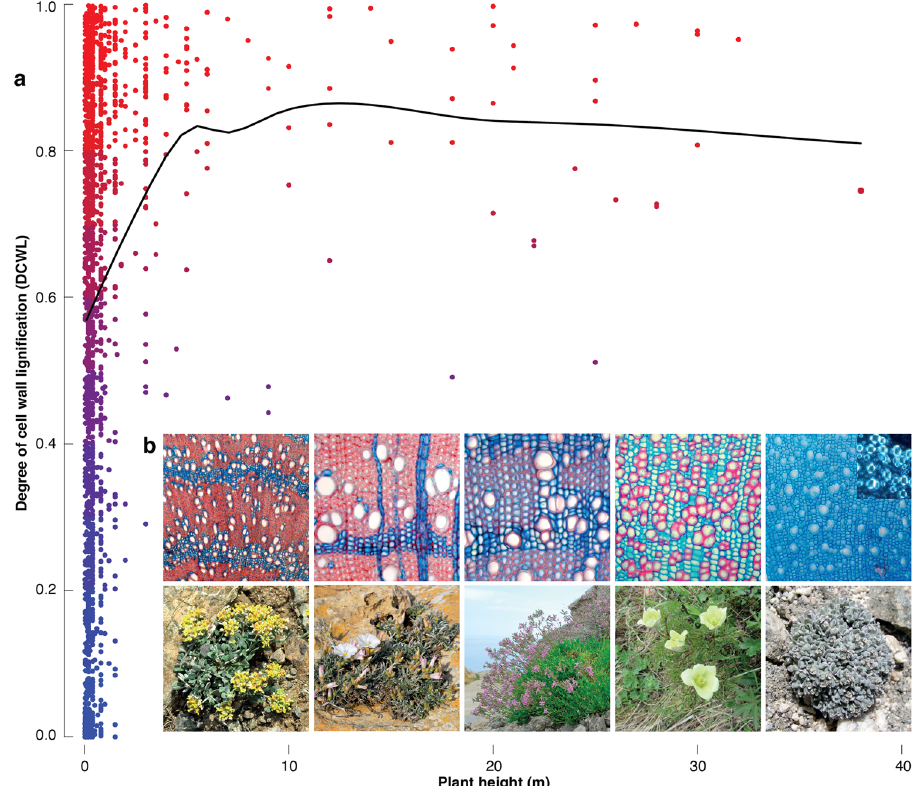
Fig. 4 Relation between cell wall ligni fi cation and plant height. a Dots represent 1770 different species (i.e., one sample per species), with colours ranging from blue (less ligni fi ed) to red (ligni fi ed). The curve is a locally weighted polynomial Loess Regression that is fi tted to the mean DCWL values of each 10- cm plant height class. b Microscopically magni fi ed double-stained thin sections of fi ve species of angiosperms dicotyledonous, which visualise the wide range of DCWL in herbs since Safranin and Astra Blue stain ligni fi ed and less ligni fi ed cell walls red and blue, respectively: Alyssum akamasicum is a perennial herb that can reach up to ten cm in vertical height and contains wood with ligni fi ed vessels, fi bres, and less ligni fi ed parenchyma cells, but no rays (100×). Convolvulus oleifolius is a creeping shrub that can reach up to 50 cm in horizontal length and contains xylem with ligni fi ed vessels, fi bres and less ligni fi ed parenchyma cells and rays (200×). Silene fruticosa is a perennial herb that can reach up to 15 cm in vertical height and contains xylem with ligni fi ed vessels, fi bres, and less ligni fi ed parenchyma cells but no rays (200×). Pulsatilla alpina is a perennial herb that can reach up to 15 cm in vertical height and contains xylem with less ligni fi ed vessels and parenchyma cells, but no fi bres and rays (200×). Ladakiella klimesii is a perennial herb that can reach up to ten cm in vertical height and contains xylem with almost non-ligni fi ed vessels and parenchyma cells, but no fi bres and rays (200×). The inset fi gure (top right) shows a portion of the microsection under polarised light to highlight crystalline cellulose (bright) that increases cell wall mechanical properties in less- ligni fi ed vessels (200×). All photos are original and have been taken by one of the